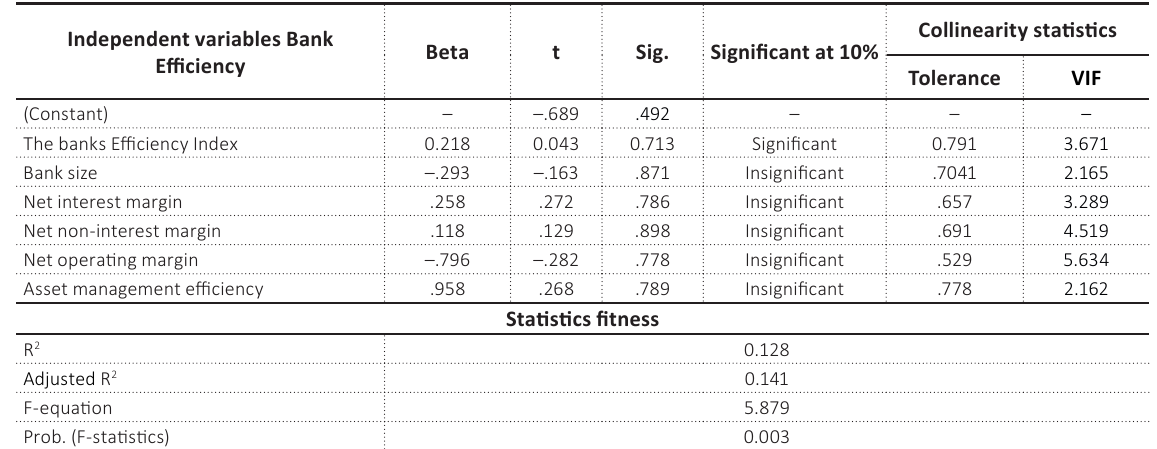
Table 5. Analysis output for Model